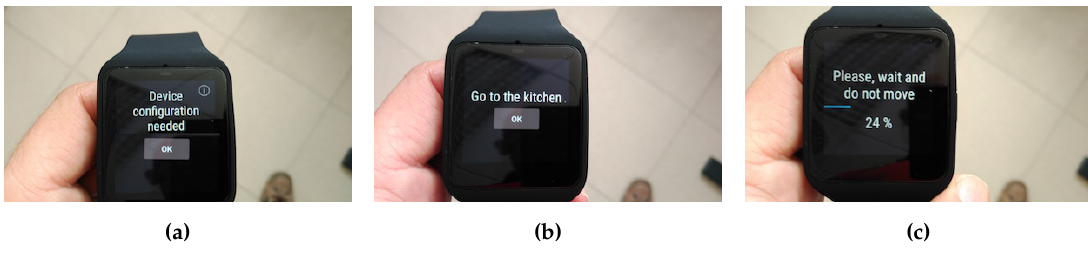
Figure 6. Some procedure steps to map the environment and create the Machine Learning